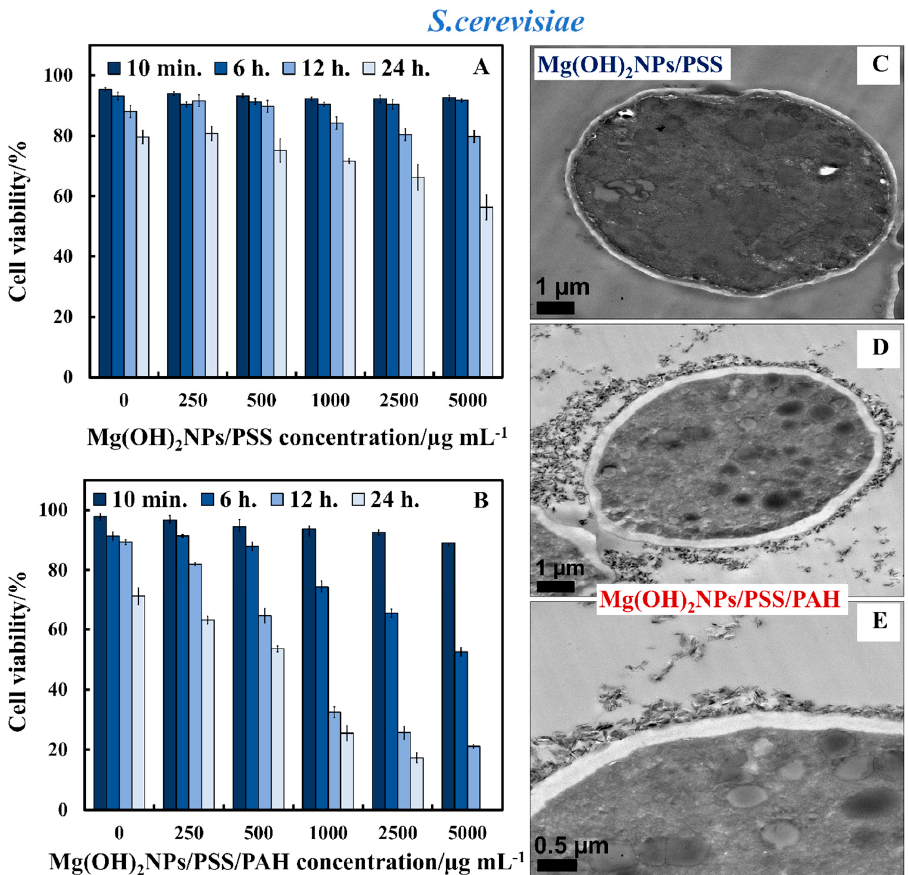
Figure 9. S. cerevisiae cell viability as a function of nanoparticle concentration after incubation for up to 24 h with ( A ) Mg(OH) 2 NPs/PSS and ( B ) Mg(OH) 2 NPs/PSS/PAH. TEM images of S. cerevisiae cells incubated for 24 h with ( C ) Mg(OH) 2 NPs/PSS and ( D , E ) Mg(OH) 2 NPs/PSS/PAH at different